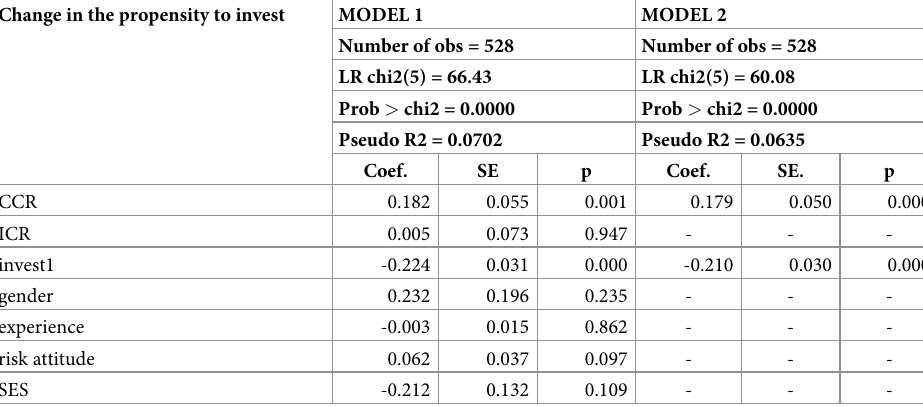
Table 4. Change in the propensity to invest. Change in the propensity to